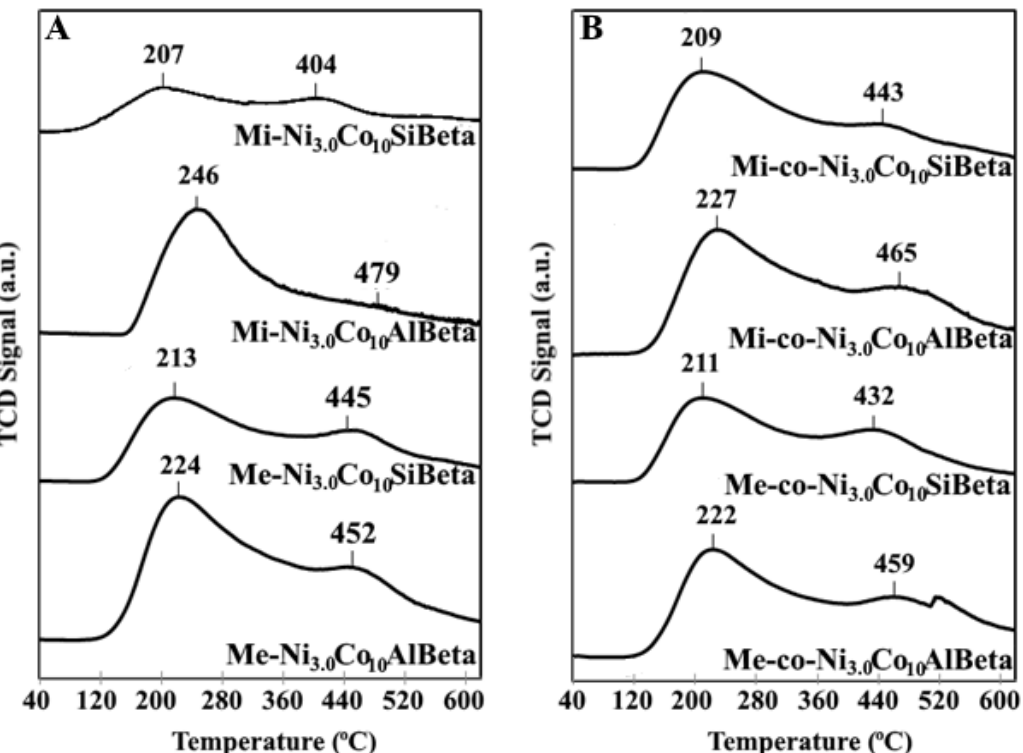
Figure 4. NH 3 -TPD profiles of ( A ) Me-Ni 3.0 Co 10 Beta, Mi-Ni 3.0 Co 10 Beta and ( B ) Me-co-Ni 3.0 Co 10 Beta, Mi-co-Ni 3.0 Co 10 Beta.